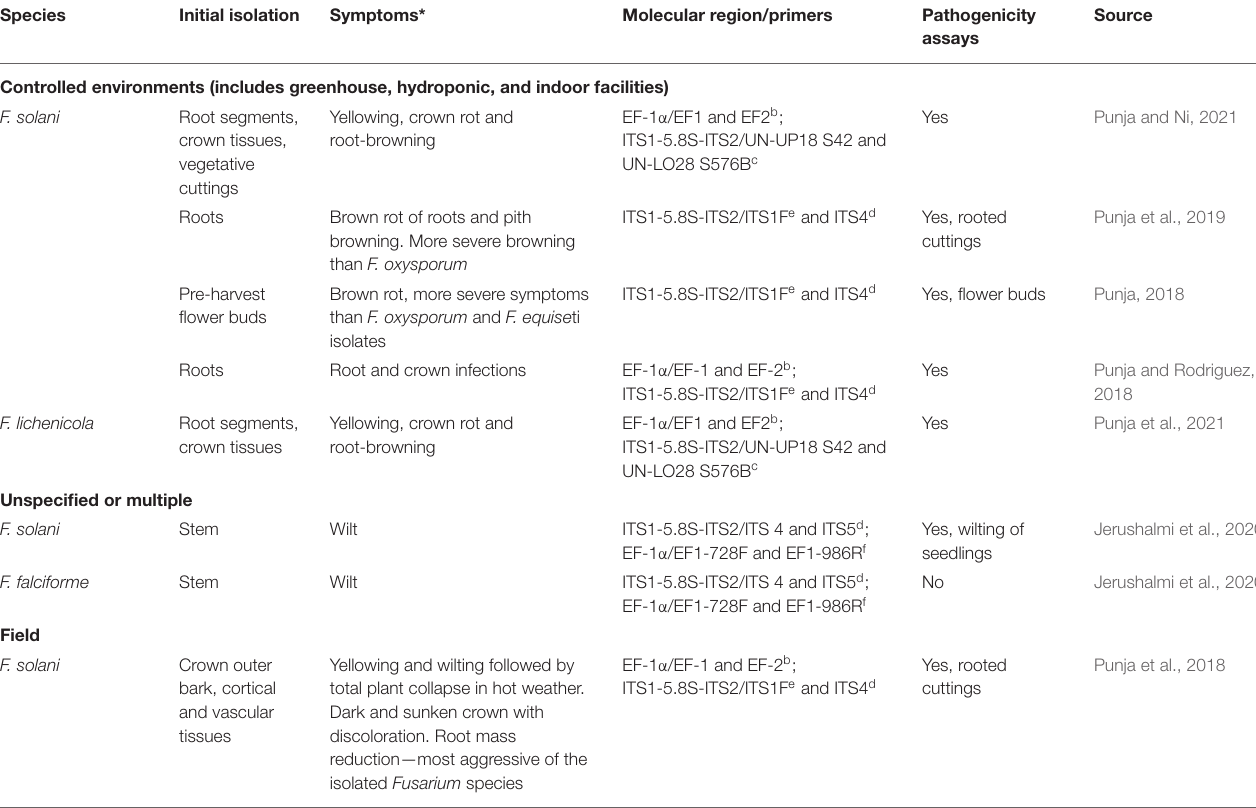
TABLE 3 | Diseases reported in C. sativa caused by members of the Fusarium solani species complex (FSSC) a . Species